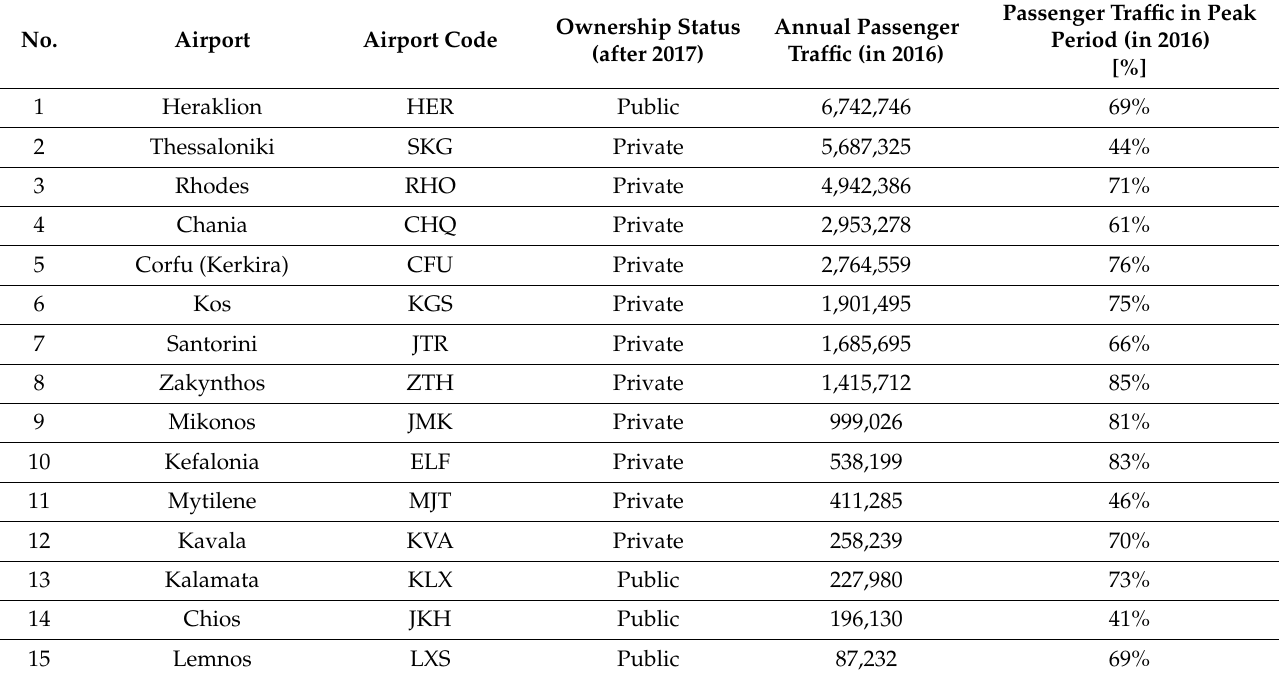
Table 2. Characteristics of the study airports in Greece (sorted by their annual passenger traffic).